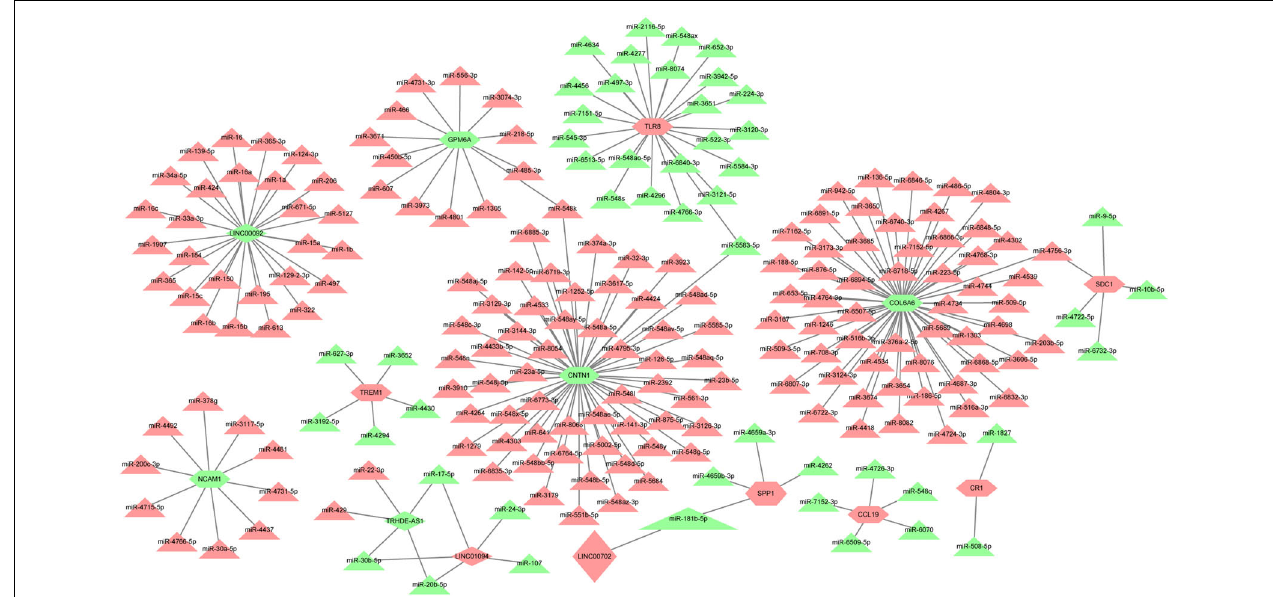
FIGURE 7 | The LncRNA-miRNA-mRNA regulatory network for CAVD. Red color means upregulated genes, and green color represents downregulated genes. Rhombus represents LncRNAs, triangles represent miRNAs, and shuttle shapes represent mRNAs.